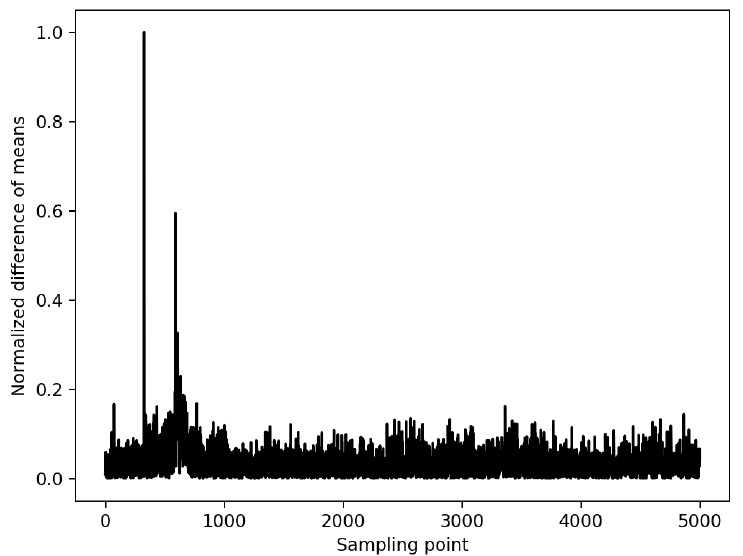
Figure 9. Differential power analysis on AES 128-bit with 100,000 traces on Atmega128 8-bit